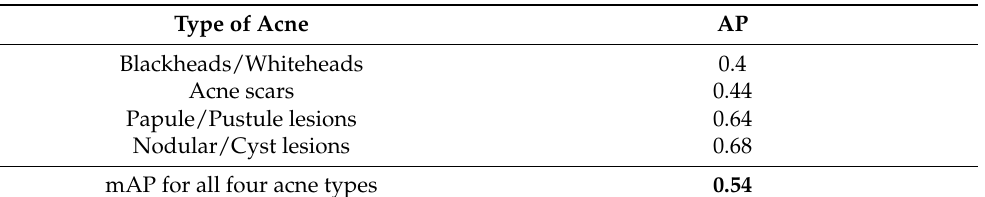
Figure 4. Precision–recall curve of object detection of each acne type. Table 4. Average Precision (AP) for each acne type and mean Average Precision (mAP) for all four acne types.